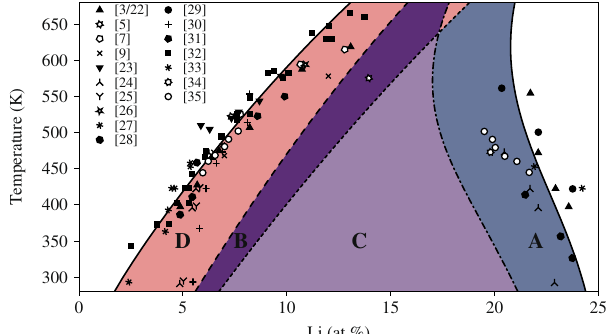
Figure 1. Phase diagram of the pseudobinary Al(-Cu)-Li system as determined from the described BWG model parametrized using the experimental data sets reported in refs 3, 5, 7, 9, 22–35. A–D denote distinctive regions of thermodynamic ordering and decomposition stability as described in the text. Together they form the metastable miscibility gap between solid solution and L1 2 phase. In the figure, open symbols refer to microscopy techniques, full symbols refer to bulk and spectroscopy techniques and line symbols refer to scattering